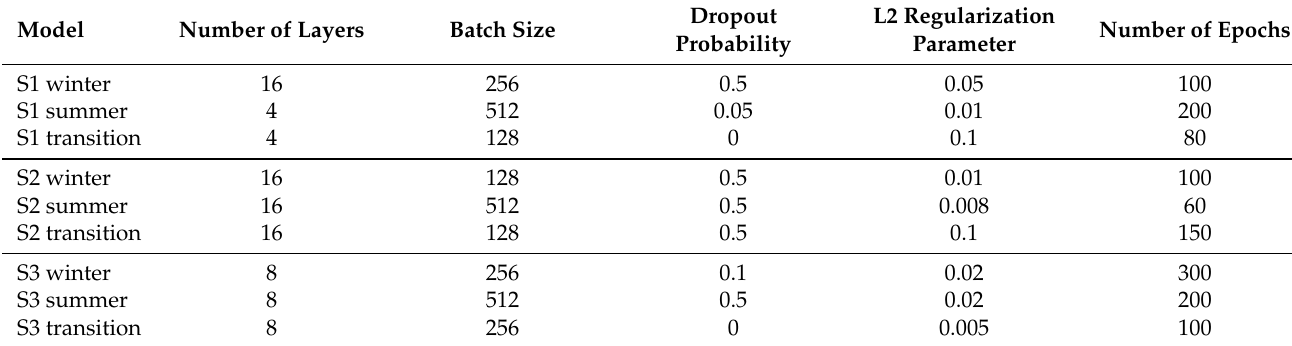
Table 3. Analyzed deep-learning